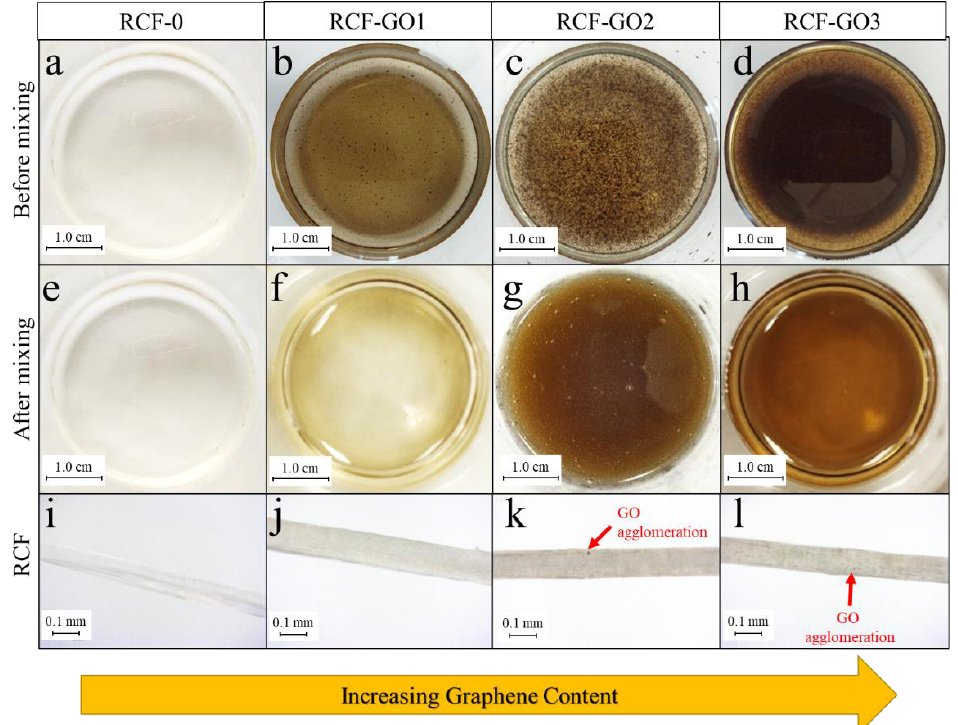
Figure 5. Optical images of ( a – c ) GO in cellulose solution prior to regeneration (coagulation); ( e – h ) GO in cellulose solution after mixing for 30 min prior to regeneration, and ( i – l ) RCF images captured using a Dino-Lite microscope at 470 × magnification.